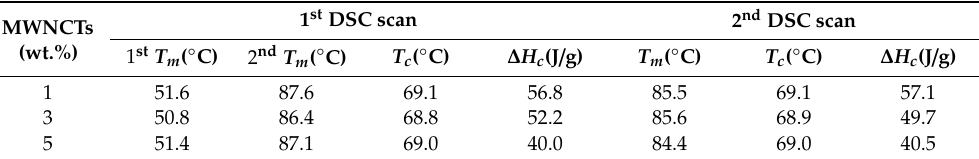
Table 1. DSC results for EVA / MWCNT composites.